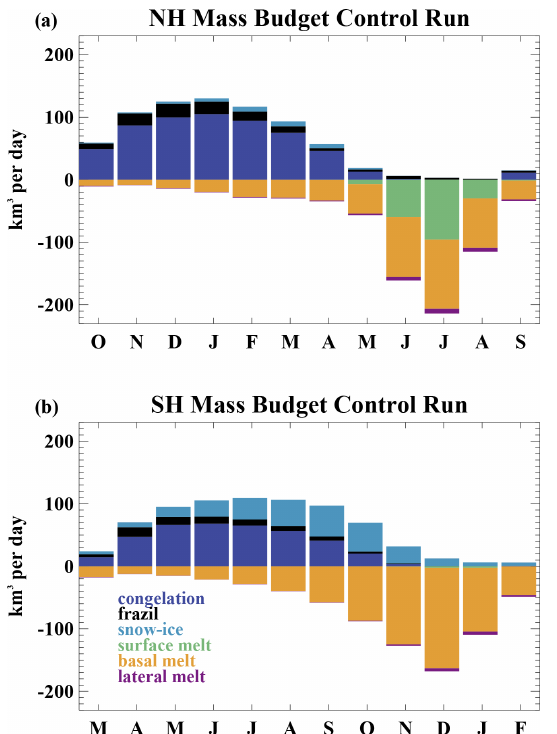
Figure 2. Annual cycle of the climatological ice volume budgets in the F snow = 1 preindustrial control run for the (a) Northern Hemi- sphere and (b) Southern Hemisphere. The volume budgets can be directly converted into mass budgets using the constant sea ice den- sity of 917kgm − 3 used in the model. Note that the annual cycle is shifted in both hemispheres to begin with the ice growth season (starting in October for panel a and March for panel b ). Values are computed over the entire hemisphere.